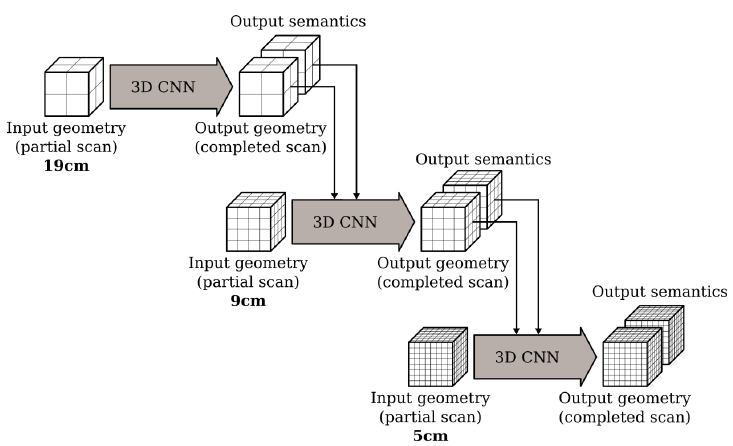
Figure 2. Overview of the hierarchical coarse-to-fine strategy.